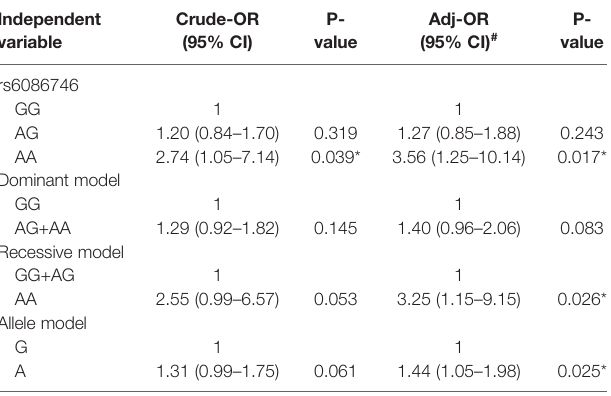
TABLE 3 | Association of the rs6086746 with osteopenia. Independent